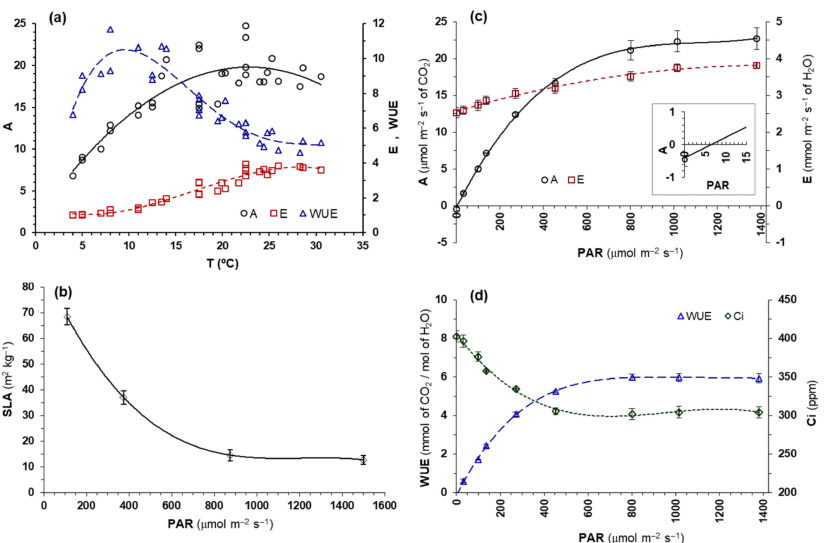
Figure 4. ( a ) Net photosynthetic rate (A, µ mol m − 2 s − 1 of CO 2 ), transpiration rate (E, mmol m − 2 s − 1 of H 2 O) and water use efficiency (EUA, mmol of CO 2 /mol of H 2 O) of Picris willkommii as a function of ambient temperature, measured under saturating light. A = − 0.035 T 2 + 1.601 T + 1.543 (R 2 = 0.754). E = − 0.0005 T 3 + 0.024 T 2 − 0.219 T – 1.607 (R 2 = 0.947). WUE = − 0.0001 T 4 + 0.009 T 3 – 0.285 T 2 + 3.308 T – 2.154 (R 2 = 0.892). ( b ) Relationship between specific leaf area (SLA) and light radiation (PAR, µ mol m − 2 s − 1 of photons in the range 400 − 700 nm wavelength). The bars indicate the standard error. Sample size = 22 plants per light treatment. ( c ) Net photosynthetic rate (A) and transpiration rate (E), as well as ( d ) water use efficiency (WUE) and internal CO 2 concentration of the leaf mesophyll (Ci), of Picris willkommii measured at 22 ◦ C and different light intensities. A = 2 × 10 − 8 x 3 − 5 × 10 − 5 x 2 + 0.058 x − 0.155 (R 2 = 0.999); E = − 6 × 10 − 7 x 2 + 0.002 x + 2.571 (R 2 = 0.991);